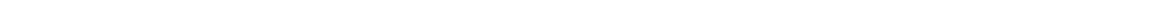
Fig. 3 TRAPed cells over-represent subsets of highly active neurons to the inducing stimulus. a Schematic representation of the three neuronal groups from two experimental groups. We recorded from TRAPed and non-TRAPed neurons in mice stimulated with WC (TRAP WC and non-TRAP WC , respectively) and from TRAPed neurons in mice that were not stimulated with sound (TRAP NS , green). Example photomicrograph of the electrode (green) and BFP signal (blue) is shown from each group. Scale bar, 10 μ m. b Top: average PSTHs of all neurons in response to WC from three neuronal groups. Bottom: raster plots of all the recorded neurons (TRAP WC ; n = 33 neurons, N = 8 mice, non-TRAP WC ; n = 28 neurons, N = 8 mice, TRAP NS ; n = 29 neurons, N = 9 mice). Each raster of each neuron is composed of 60 trials. Red ticks correspond to spikes that were statistically above the baseline rate around a syllable. The voltage trace of the WC stimulus is shown beneath the rasters. c Plots of evoked vs spontaneous spike rates from all the recorded neurons in all groups shown in ( b ). Each dot indicates the mean fi ring rate of a single neuron. d Plots of the mean ( ± SEM) evoked vs spontaneous spike rates of the neurons shown in ( b ) and ( c ). e Basic response properties to WC of all neurons from the three groups. Each circle represents an individual cell. The line indicates the mean. Spontaneous rate was not different between groups ( p = 0.29, Kruskal – Wallis test). TRAPed neurons in the TRAP WC mice have higher evoked spike rate and responded to a higher number of syllables in the call as compared to the other groups (* p < 0.05; ** p < 0.01; *** p < 0.001; ns, not signi fi